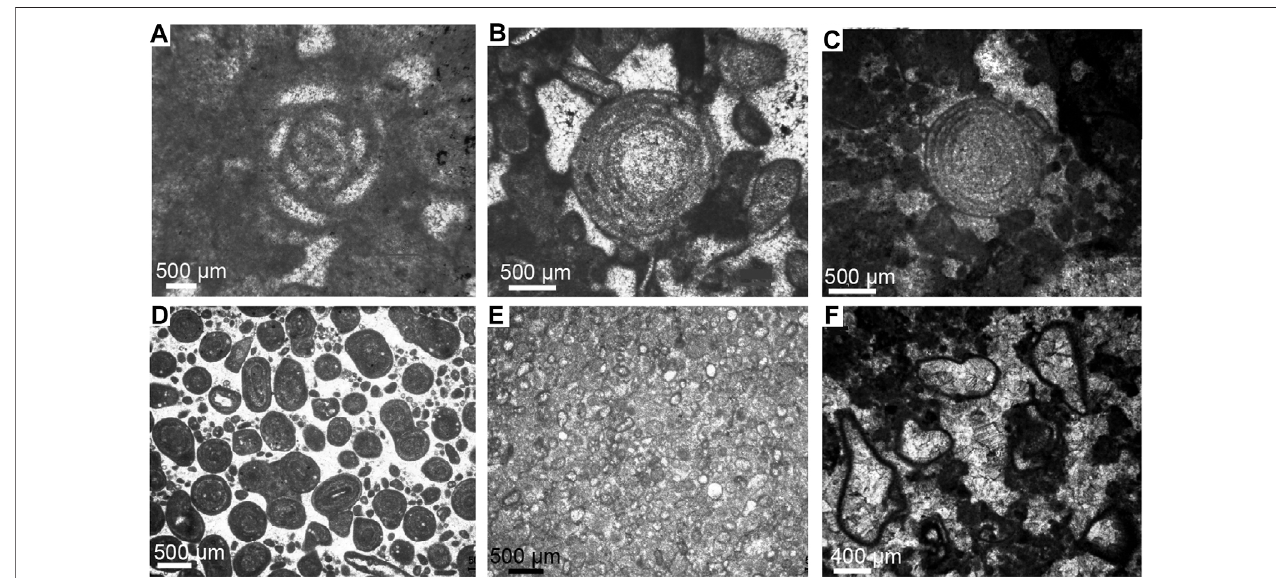
FIGURE 3 | Microfacies types in units A, B and C. (A) Glomospirella friedli in sp in Unit A; (B) grainstone with Triasina hantkeni belonging to Unit A; (C) grainstone with Triasinahantkeni ofUnit B; (D) ooidal grainstone atthetop ofUnitB; (E) calcitic sphaerule belongingtothebarreninterval betweenUnit BandUnit C; (F) grainstone with Thaumatoporella parvovesiculifera belonging to Unit